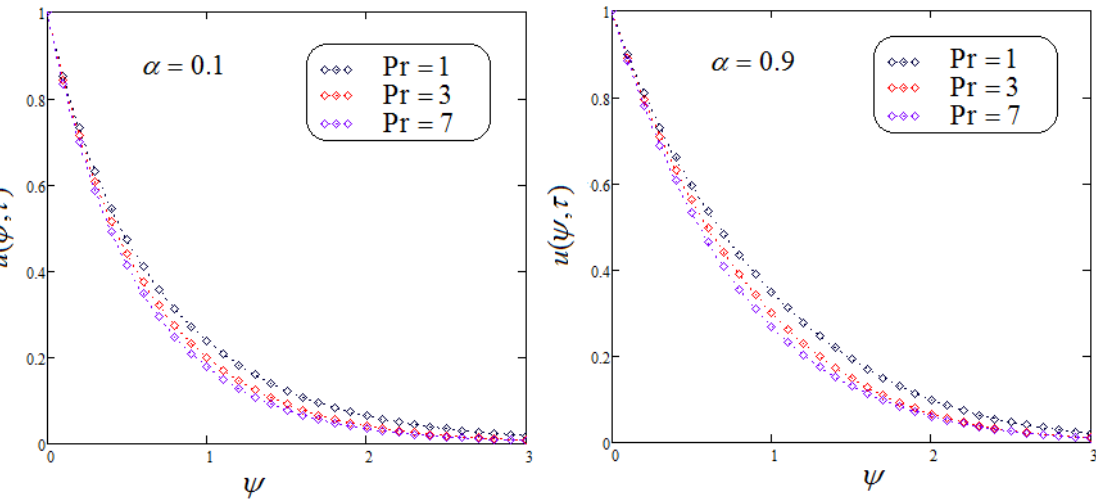
Figure 6. Trace of velocity for dissimilar values of M .